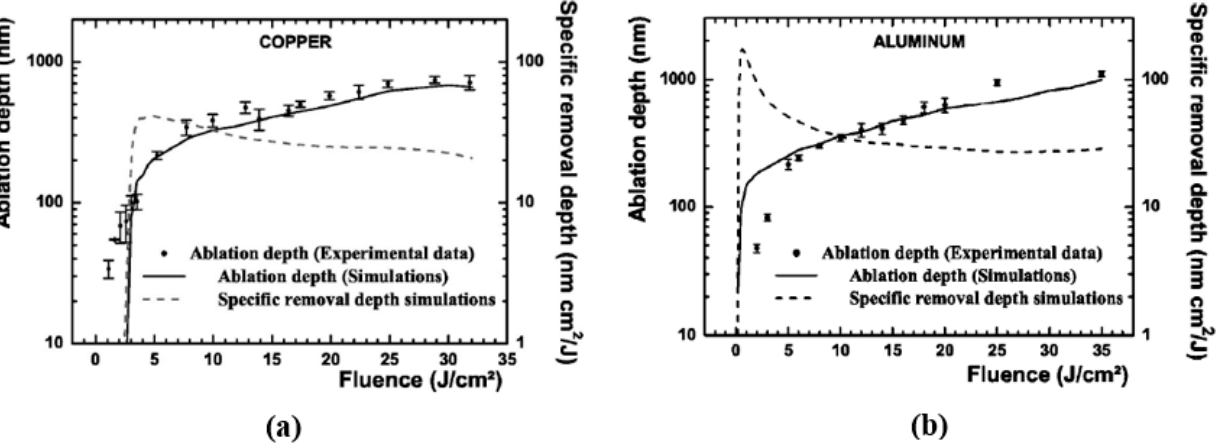
Figure 5. Experimental and numerical results of ablation depth as a function of laser fluence using a hydrodynamics model for ( a ) copper and ( b ) aluminium with a 170 fs laser pulse (Adapted from reference